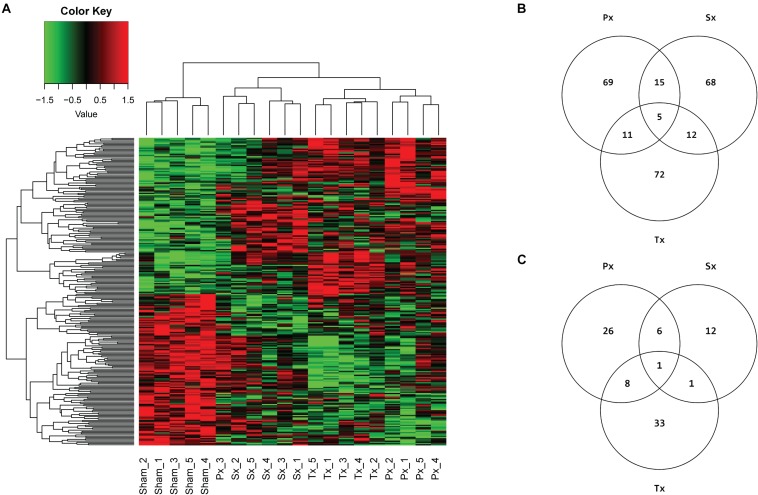
Microarray analysis of hepatic denervations. (A) Heatmap, clustered on samples and genes, with 252 unique genes resulting from top 100 DEGs of 3 comparisons (Sham vs. Px, Sham vs. Sx, Sham vs. Tx), based on p-value. Individual animals are presented in columns. Biological groups separate completely, except for sample Px3, which is aligned between Sham- and Sx-animals. (B) Venn diagram of top 100 DEGs per comparison (Px vs. Sham, Sx vs. Sham, Tx vs. Sham) and the number of overlapping genes between comparisons. (C) Venn diagram showing the number of pathways that are significantly (p < 0.05) enriched with top 5% (FDR corrected) DEGs by Sx-, Px- or Tx-denervation when compared to Sham-animals. Tx-denervation resulted in most pathways significantly enriched. One pathway was overlapping between all non-Sham denervation groups, and one other pathway overlapped between Sx- and Tx-animals. Most overlapping pathways were found between Px- and Tx-groups (9 overlapping).